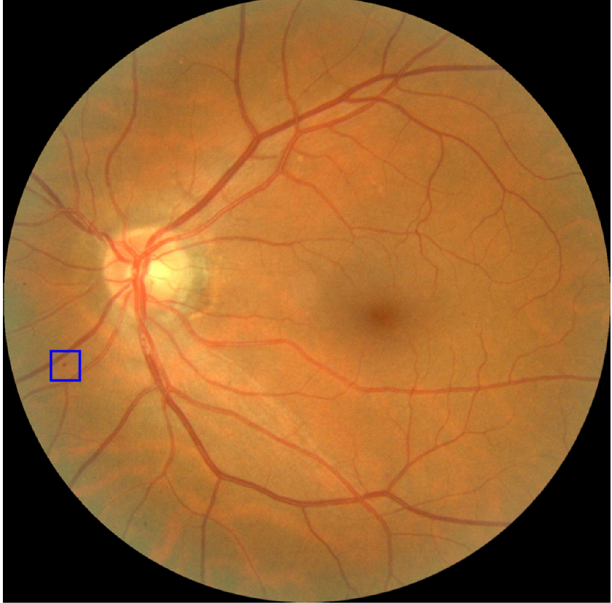
Figure 6. Fundus image with mild DR. A small sign of DR can be seen on the left side of the eye highlighted with a blue rectangle.